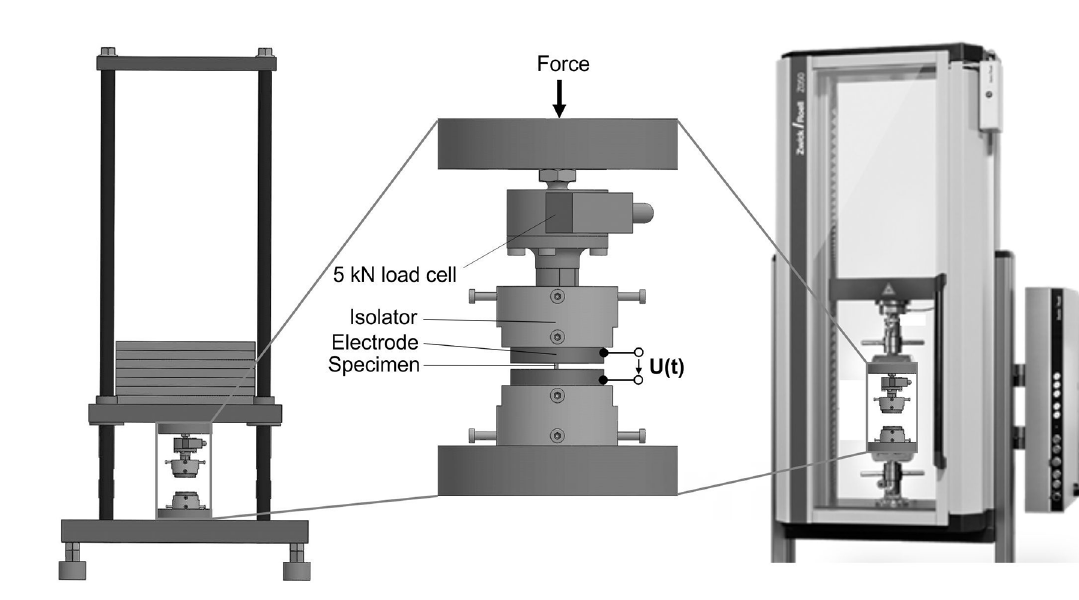
Figure 2. Compression test set-up used to apply high current density impulses at (left) constant load or (right) constant strain